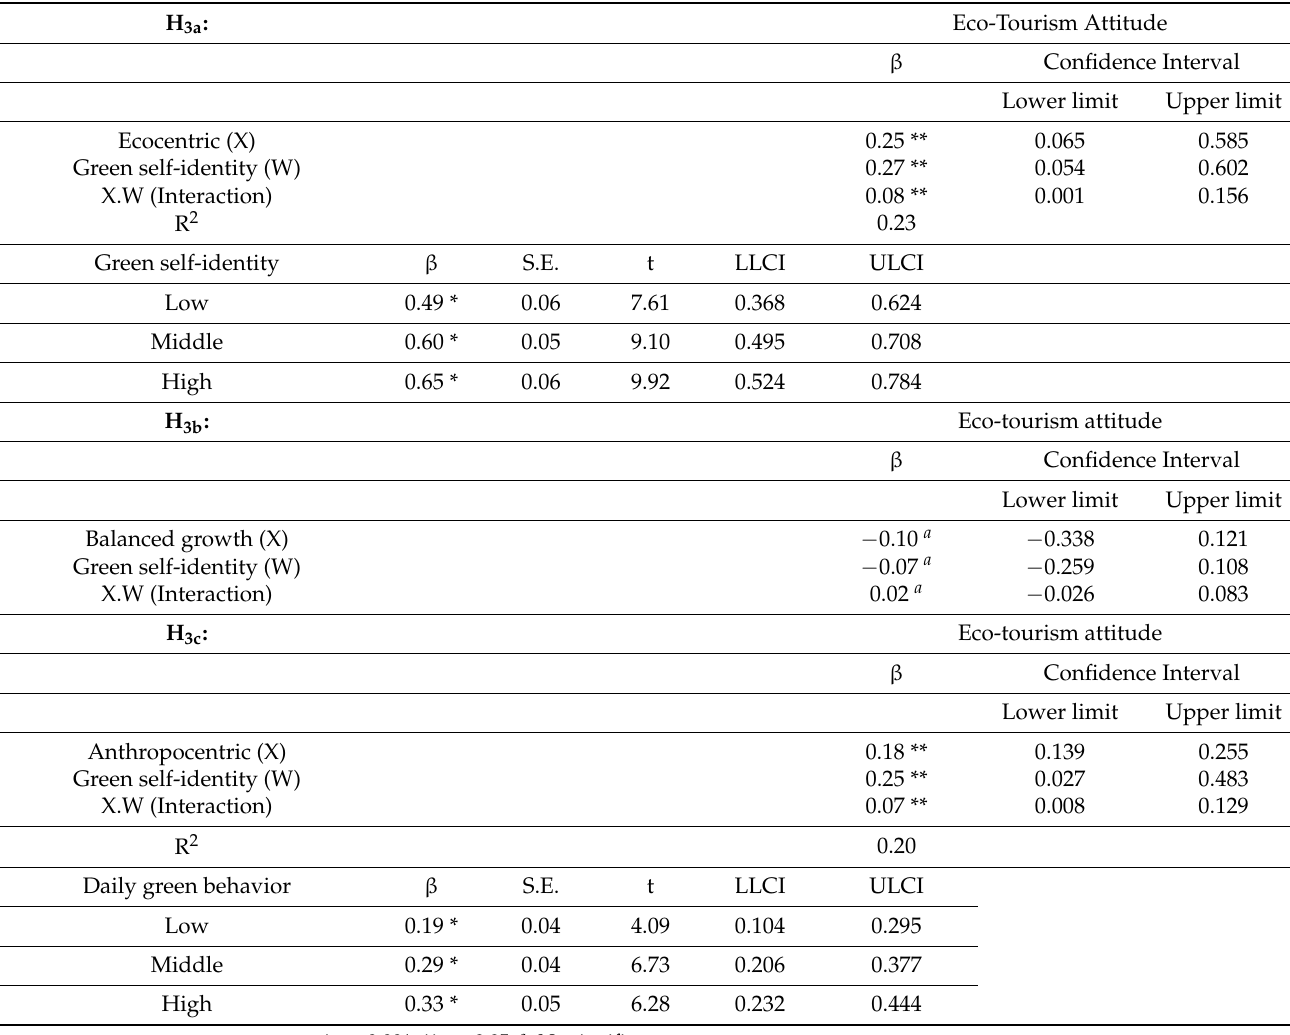
Table 5. Bootstrap regression analysis